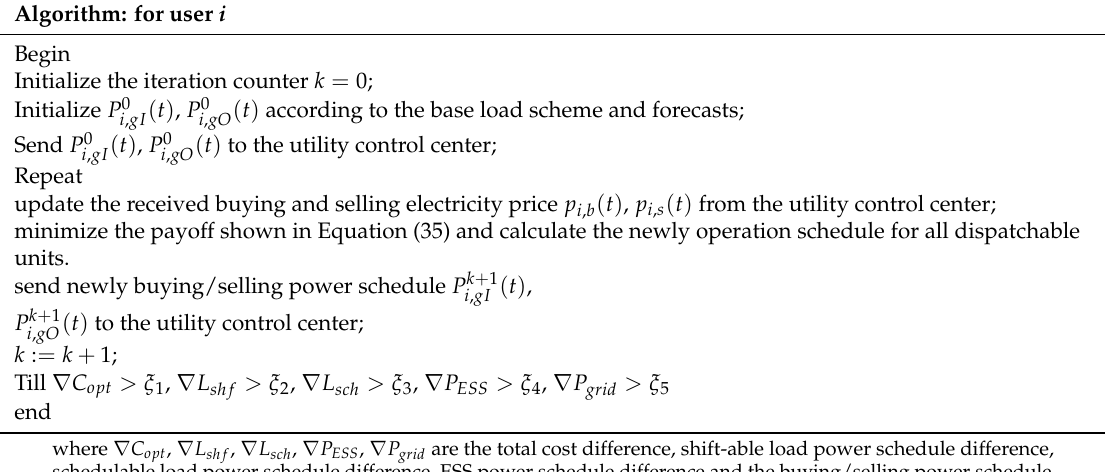
Table 1. Algorithm for distributed optimization algorithm for the energy scheduling of